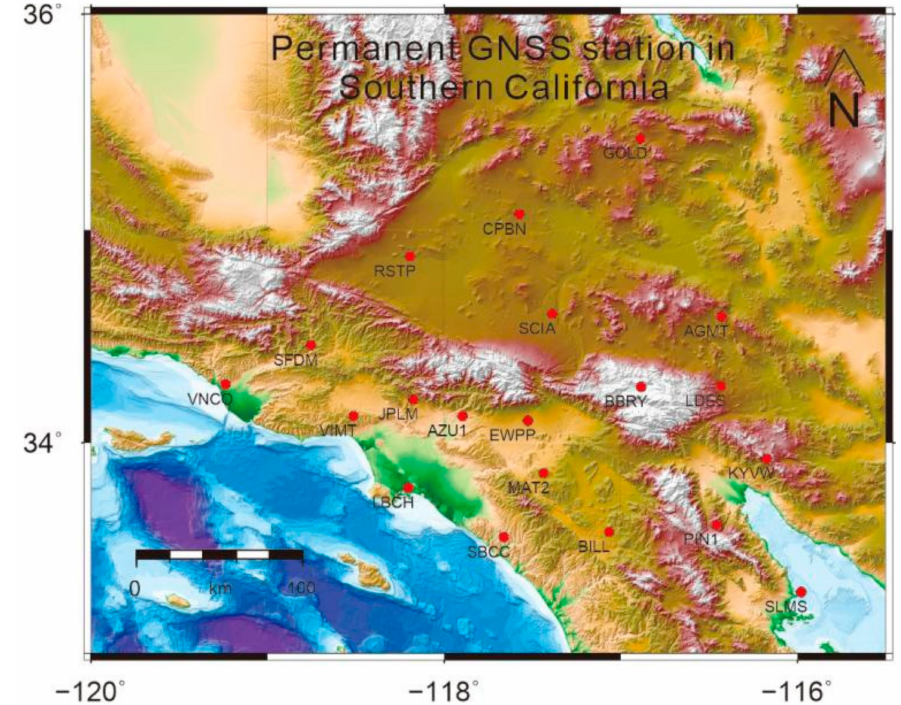
Figure 1. Map showing the locations of current GNSS stations in the southern California region. The station is installed and distributed in the local regional area.